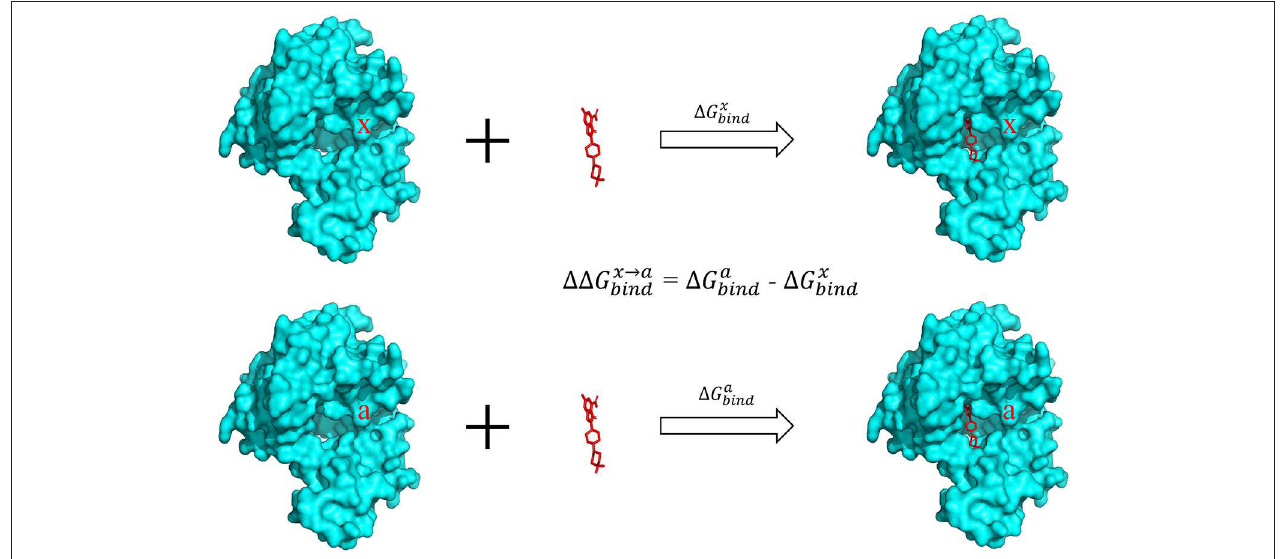
FIGURE 2 | Calculation of binding free energy with the alanine scanning approach. The contribution of a specific residue x in the pocket was calculated by mutating this residue to alanine and calculating the difference of the binding energy in the two